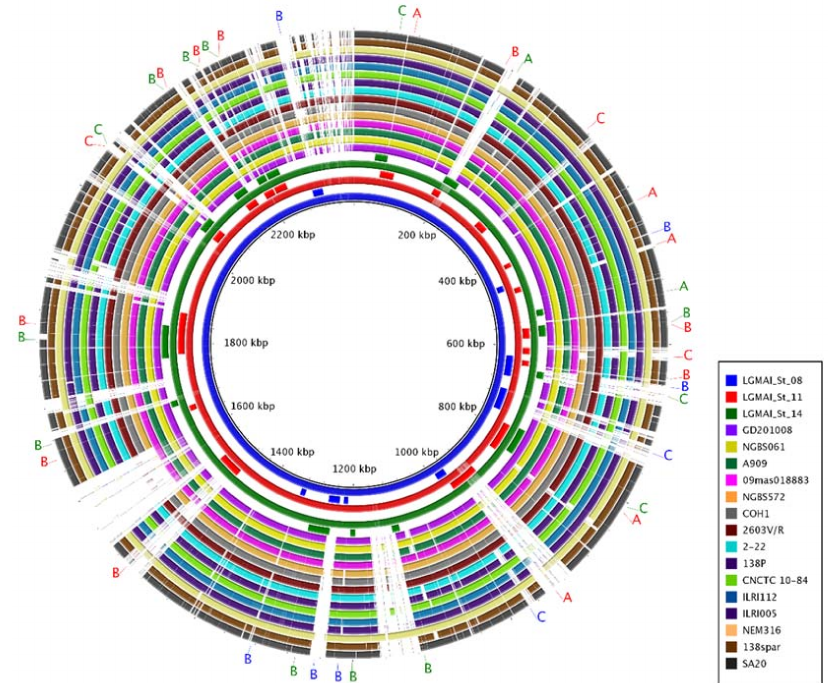
Figure 7. Circular genome map of the three LGMAI strains and 15 other well-represented Streptococcus agalactiae genomes obtained from NCBI. From the inside out, the genomes used in this analysis are in the legend order. The blue, red, and green inner circles represent the LGMAI strains. Outside each of the LGMAI’s genomes, predicted pathogenicity and resistance islands are plotted in the same colors of their corresponding strains. Letters indicate the genomic island types: A—resistance islands, B—pathogenicity islands, and C—miscellaneous islands. Letters’ colors match their corresponding genomes. This circular genome map shows nucleotide identity between the reference genome and the other genomes used in the analysis. Stronger colors register greater